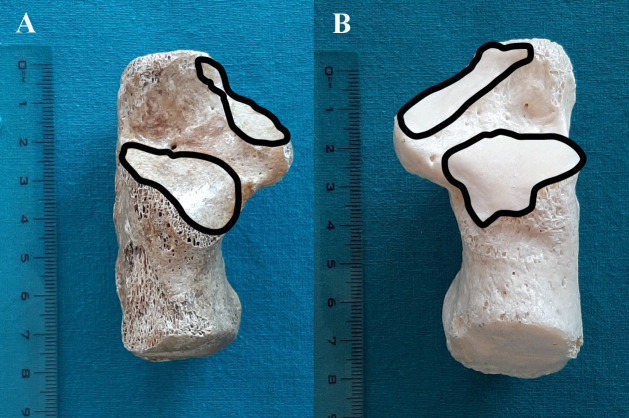
Pattern 1 of calcaneal facets for the talus: (A) pattern 1a, (B) pattern 1b.